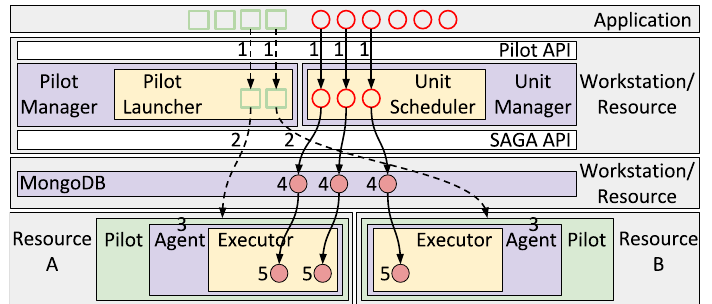
Figure 2: RADICAL-Pilot (RP) architecture and execution model. Architecture: interfaces (white), modules (purple), components (yellow), pilot entity (green), task entity called com- pute unit (red). Execution model: Pilot and units are described via the Pilot API (1); pilots are submitted to the indicated resource(s) (2); each pilot bootstraps an agent (3); compute units are scheduled onto available agent(s) (4) and executed